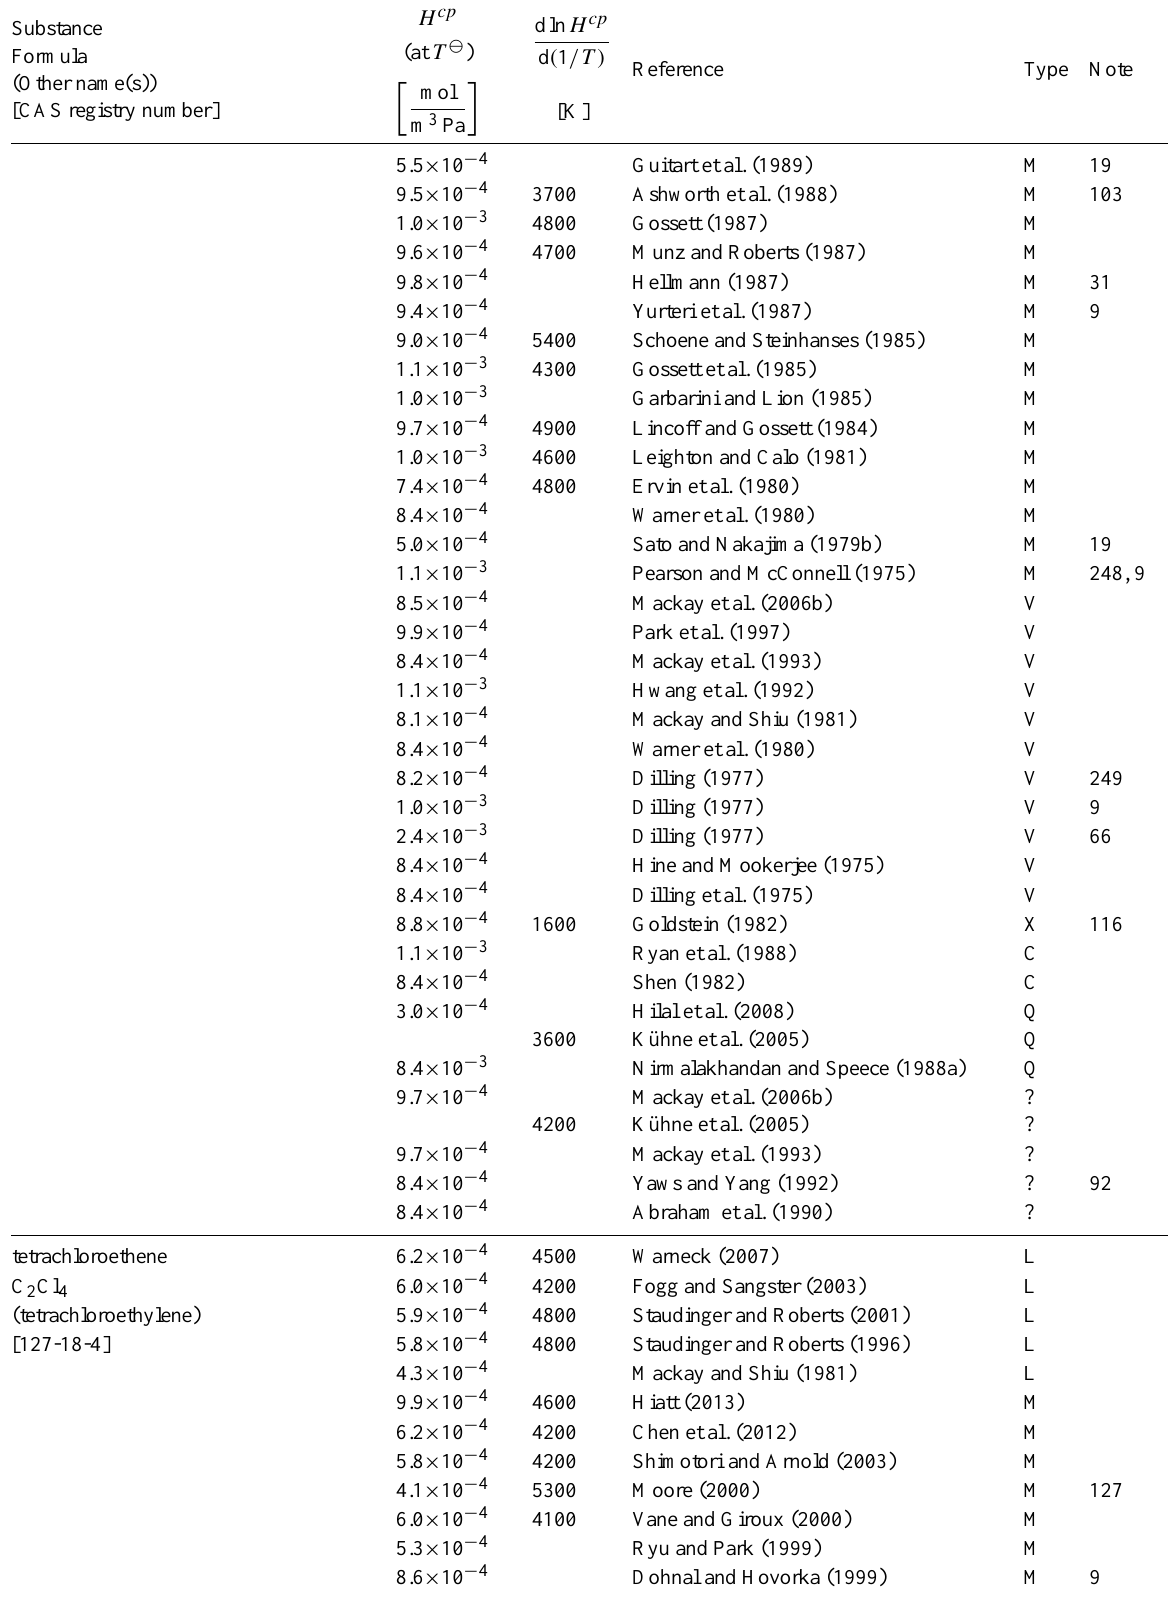
Table 6: Henry’s law constants for water as solvent